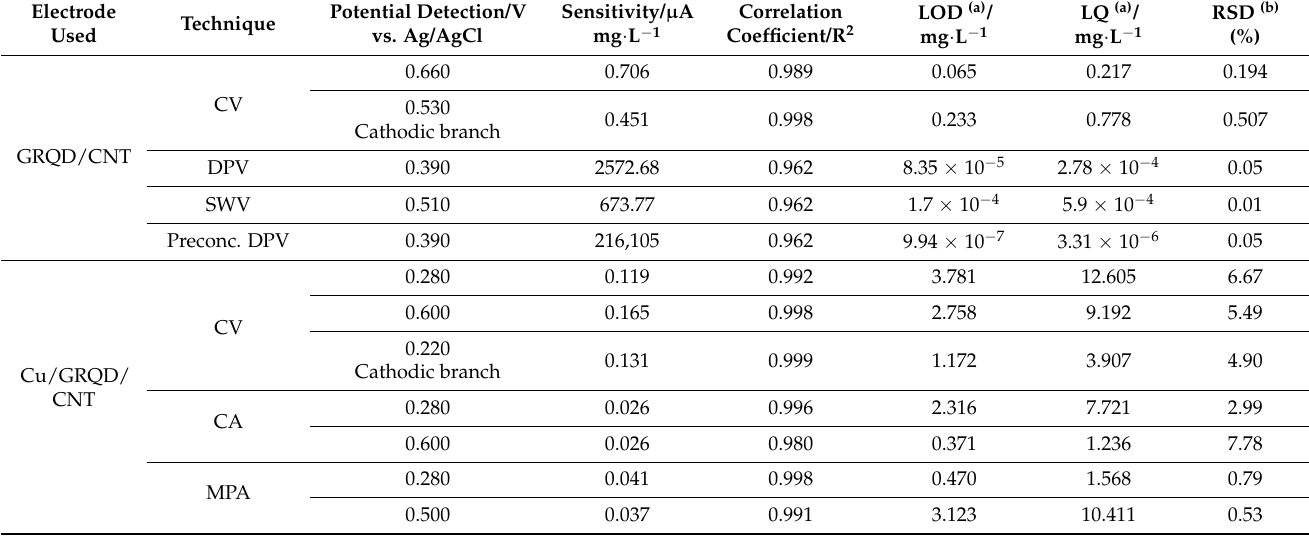
(a) LOD- Limit of detection LQ- Limit of quantification (b) RSD- Relative standard deviation determined for three